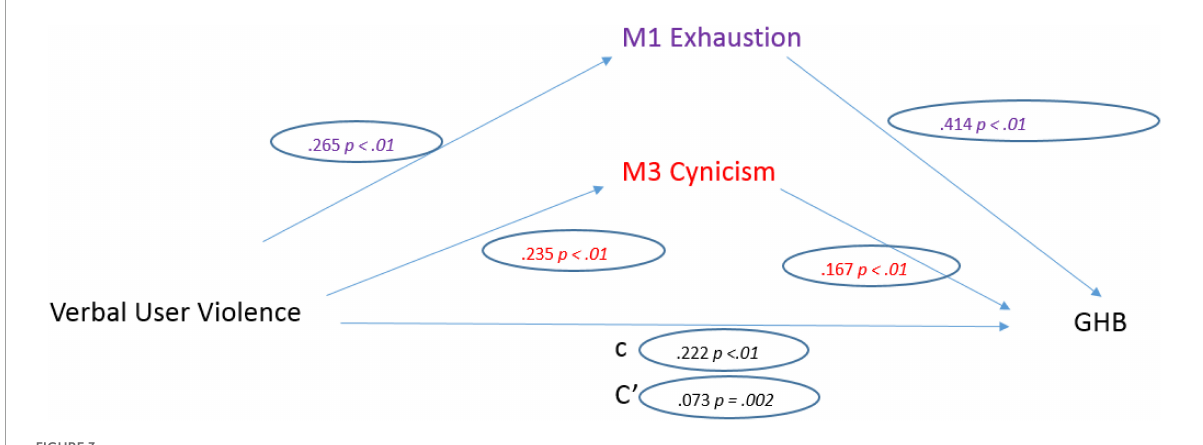
FIGURE3 Non-physical user violence